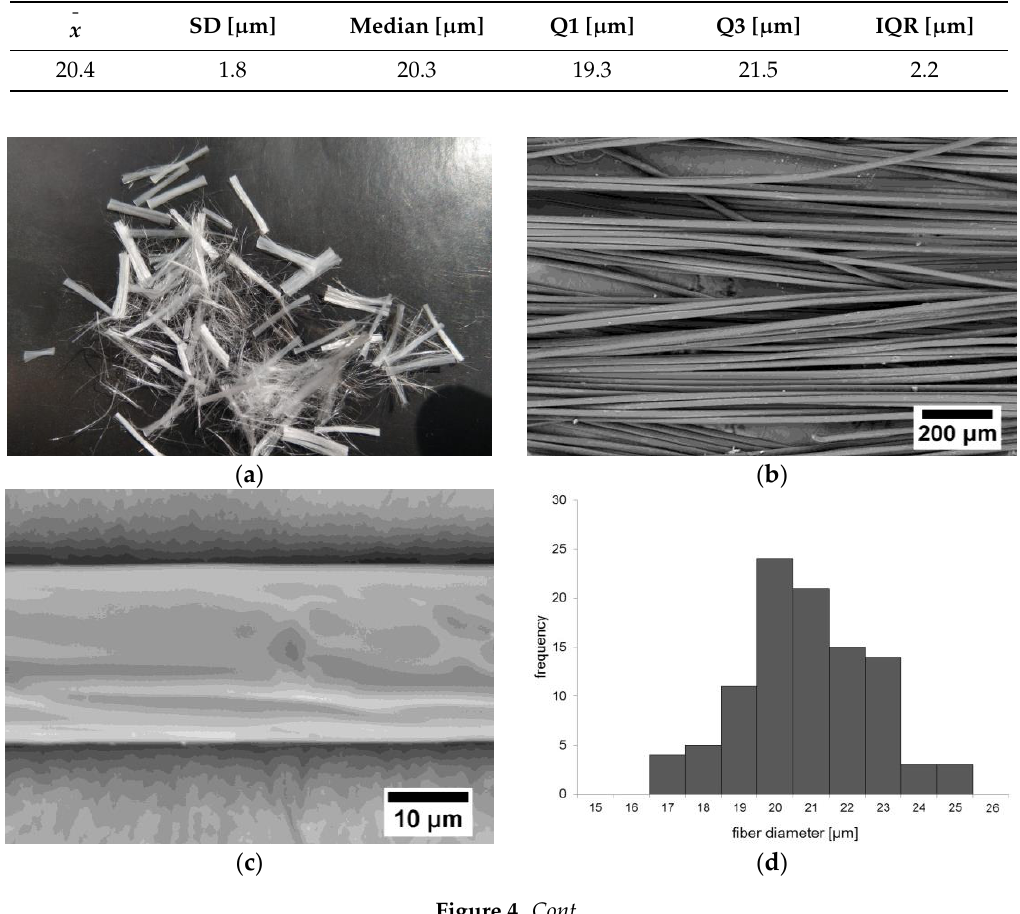
Table 1. Measurement results of the diameters of polypropylene fibers ( 𝐱̅ — mean,